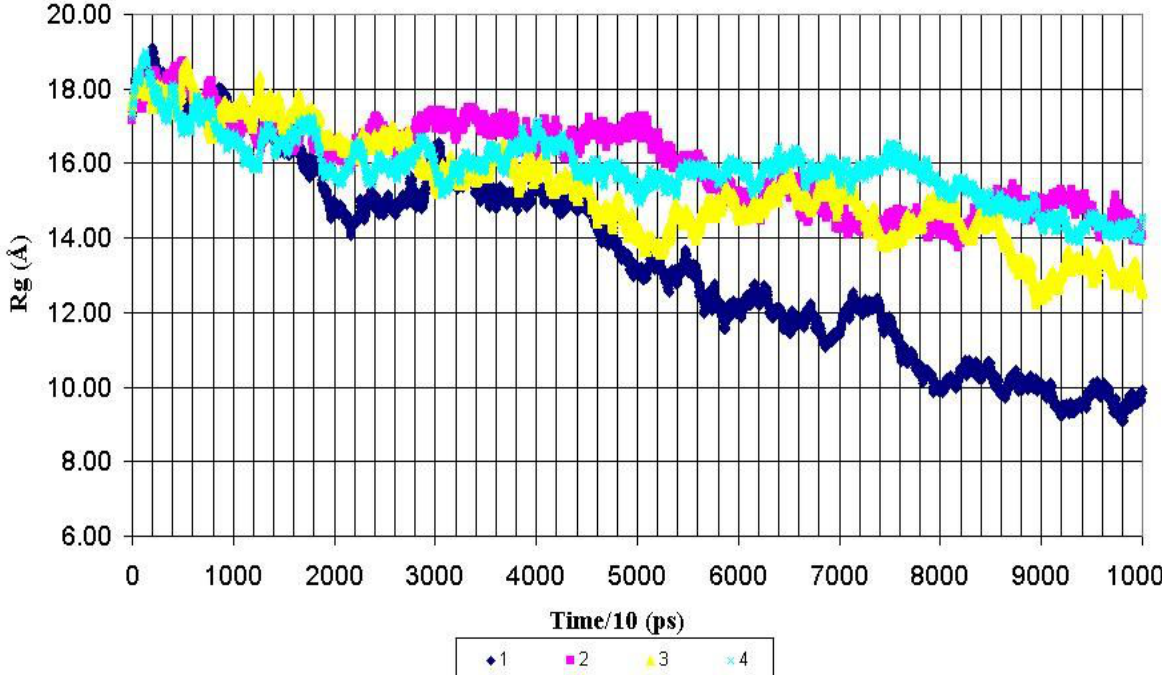
Figure 2. Radius of gyration (Rg) for backbone heavy atoms of the nonglycosylated peptide AHG21 – (1) and glycosylated peptides: AHG21 (T17) – (2), AHG21 (T5) – (3), AHG21 (T5, T17) – (4) during 1.0 ns MD simulations.